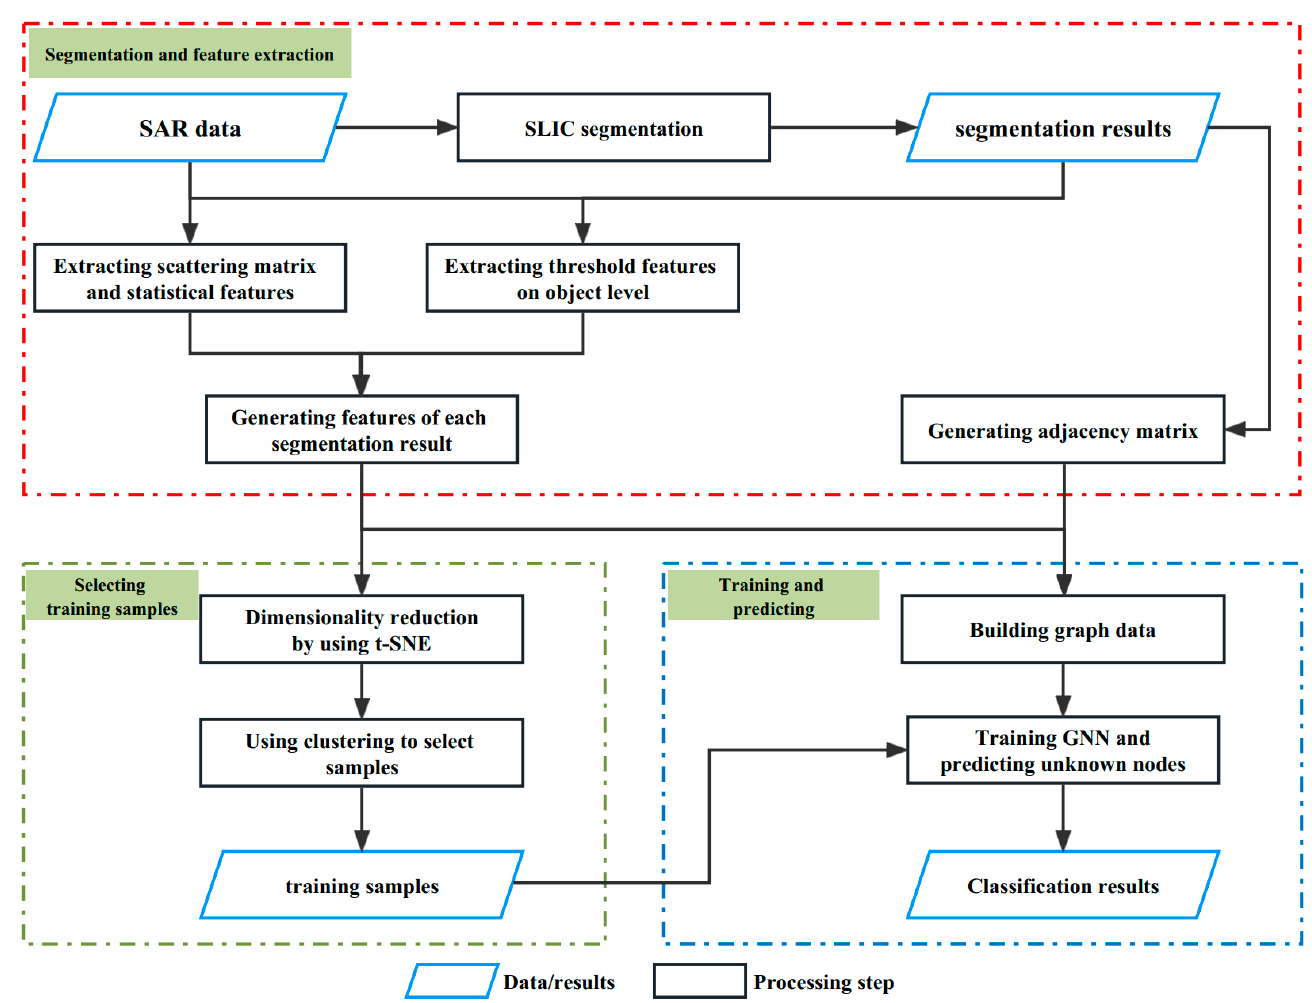
Figure 1. The flowchart of the proposed method.